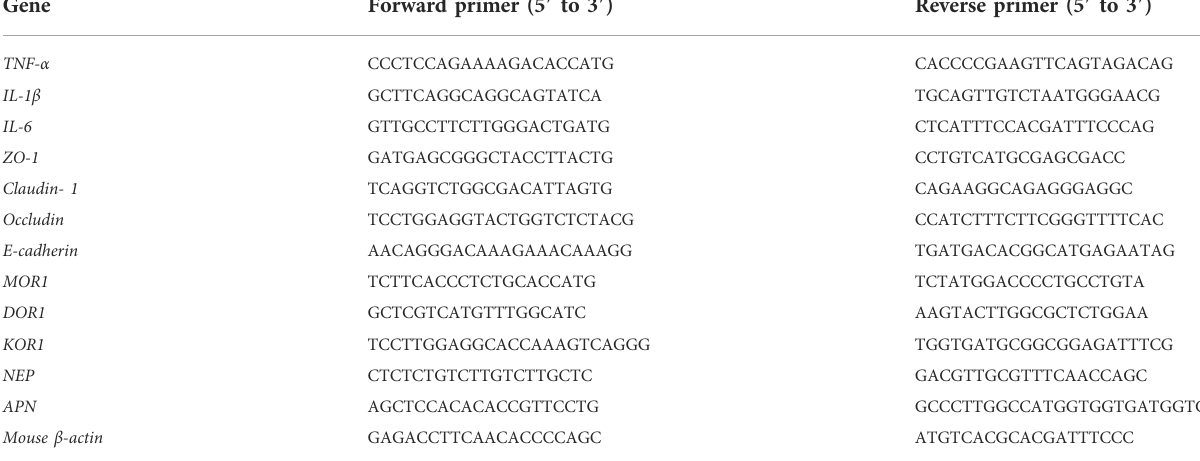
TABLE 1 Primer sequences used in the